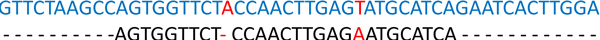
SVseq2 uses a semi-global alignment algorithm. The gaps "GTTCTAAGCC" and "GAATCACTTGGA" are without penalty. The gap at "TAC" and "T-C" are with penalty 3. The T-A mismatch are scored -1. Other Matches are scored 1 each. Total score is 23.